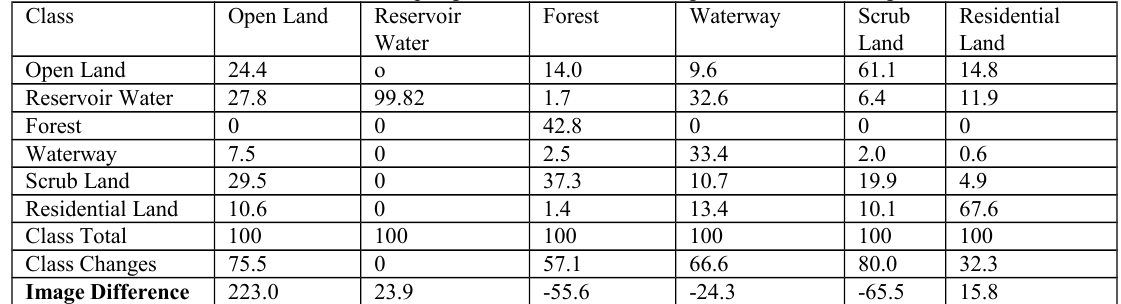
Table 6: Spring to Autumn Season Change Detection Percentage